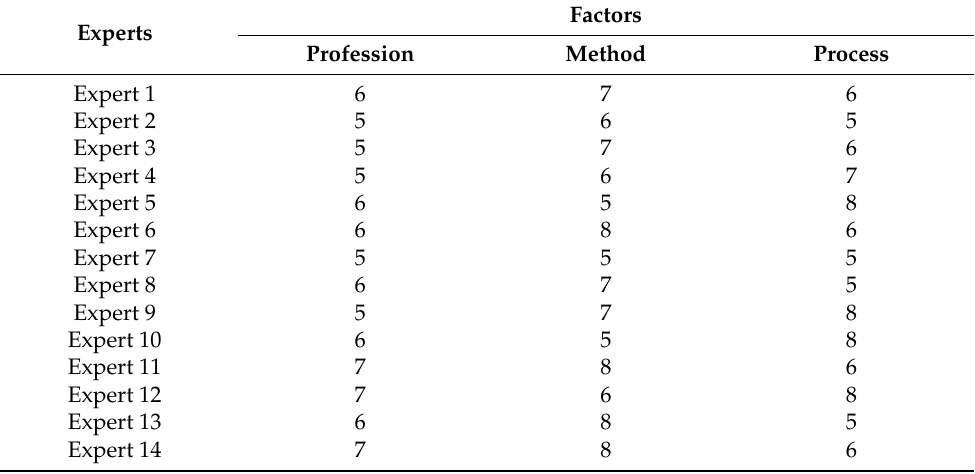
Table 2. The Evaluation of Factor Weights by